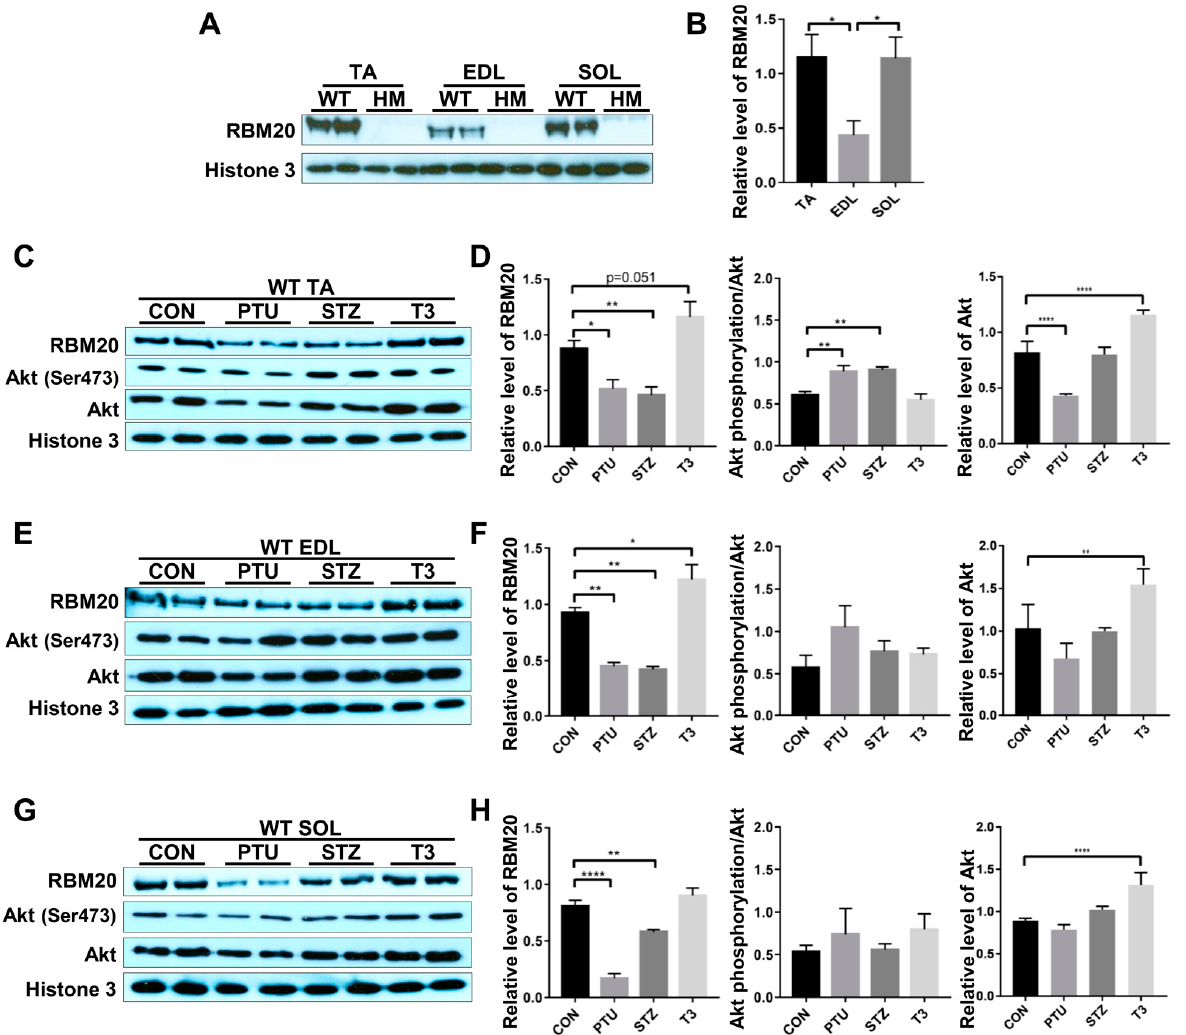
Figure 1. Hormonal effects on RBM20 expression and Akt activity in different muscle types. ( A , B ) RBM20 expression in the TA, EDL, SOL muscles of WT and HM rats. ( C , D ) RBM20 expression and Akt activity in the WT TA muscle treated with PTU, STZ and T3; ( E , F ) RBM20 expression and Akt activity in the WT EDL muscle treated with PTU, STZ and T3; ( G , H ) RBM20 expression and Akt activity in the WT SOL muscle treated with PTU, STZ and T3. WT, wildtype; HM, RBM20 homozygous knockout; CON, control; PTU, propylthiouracil; STZ, streptozocin; T3, trriodothyronine; TA, tibialis